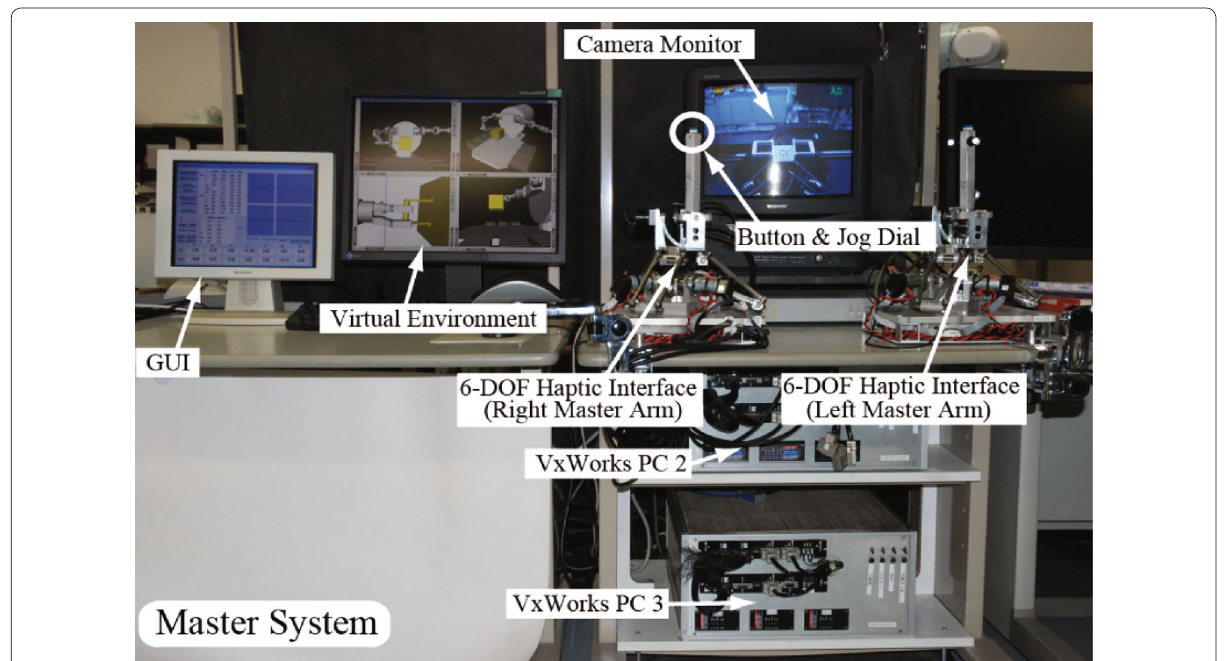
Fig. 4 Overview of the master